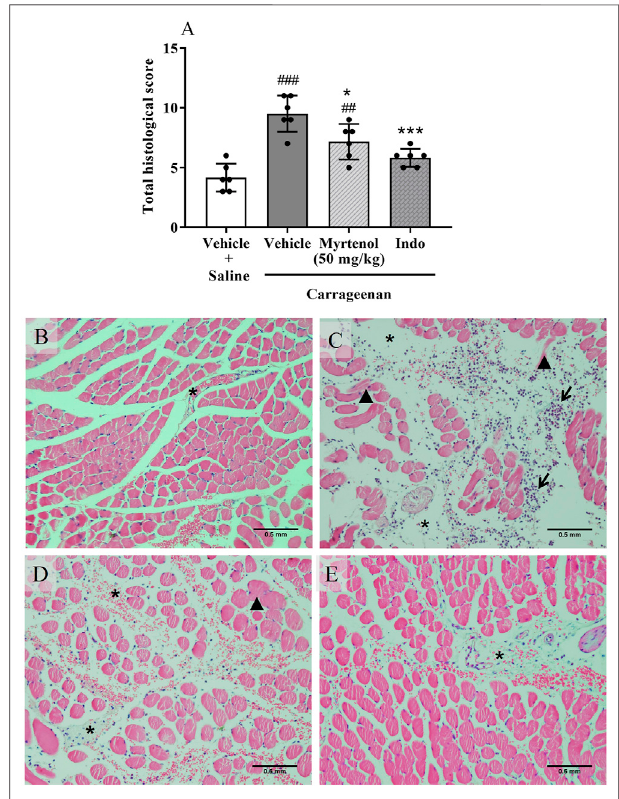
FIGURE 3 | Myrtenol decreases myeloperoxidase (MPO) activity in FIGURE 4 | Myrtenol ameliorates carrageenan-induced masseter muscle and IL-1 β levels in trigeminal ganglia and spinal trigeminal histopathological changes in mouse masseter muscle. (A – D) : representative subnucleus caudalis in carrageenan-induced orofacial in fl ammation in mice. images (40 x) of vehicle + saline (A) , vehicle + carrageenan (B) , myrtenol (A) : MPO activity (n = 8) in masseter muscle. (B,C) (n = 4 each): IL-1 β (50 mg/kg) + carrageenan (C) and indomethacin + carrageenan (D) levels in trigeminal ganglia and spinal trigeminal subnucleus caudalis groups, respectively. Asterisk: edema; arrow: in fl ammatory in fi ltrate; respectively. ANOVA [F (3,28) = 24.51, p < 0.001; F (3,12) = 10.81, p = 0.001 arrowhead: necrosis. (E) : sum of scores (n = 6). ANOVA [F (3,20) = 19.03, p < and F (3,12) = 6.79, p = 0.0081, respectively] followed by Tukey test, # p < 0.001]followedbyTukeytest, ## p < 0.01and ### p < 0.001vs.saline+vehicle, ( Continued ) * p < 0.05, *** p < 0.01 vs. carrageenan +